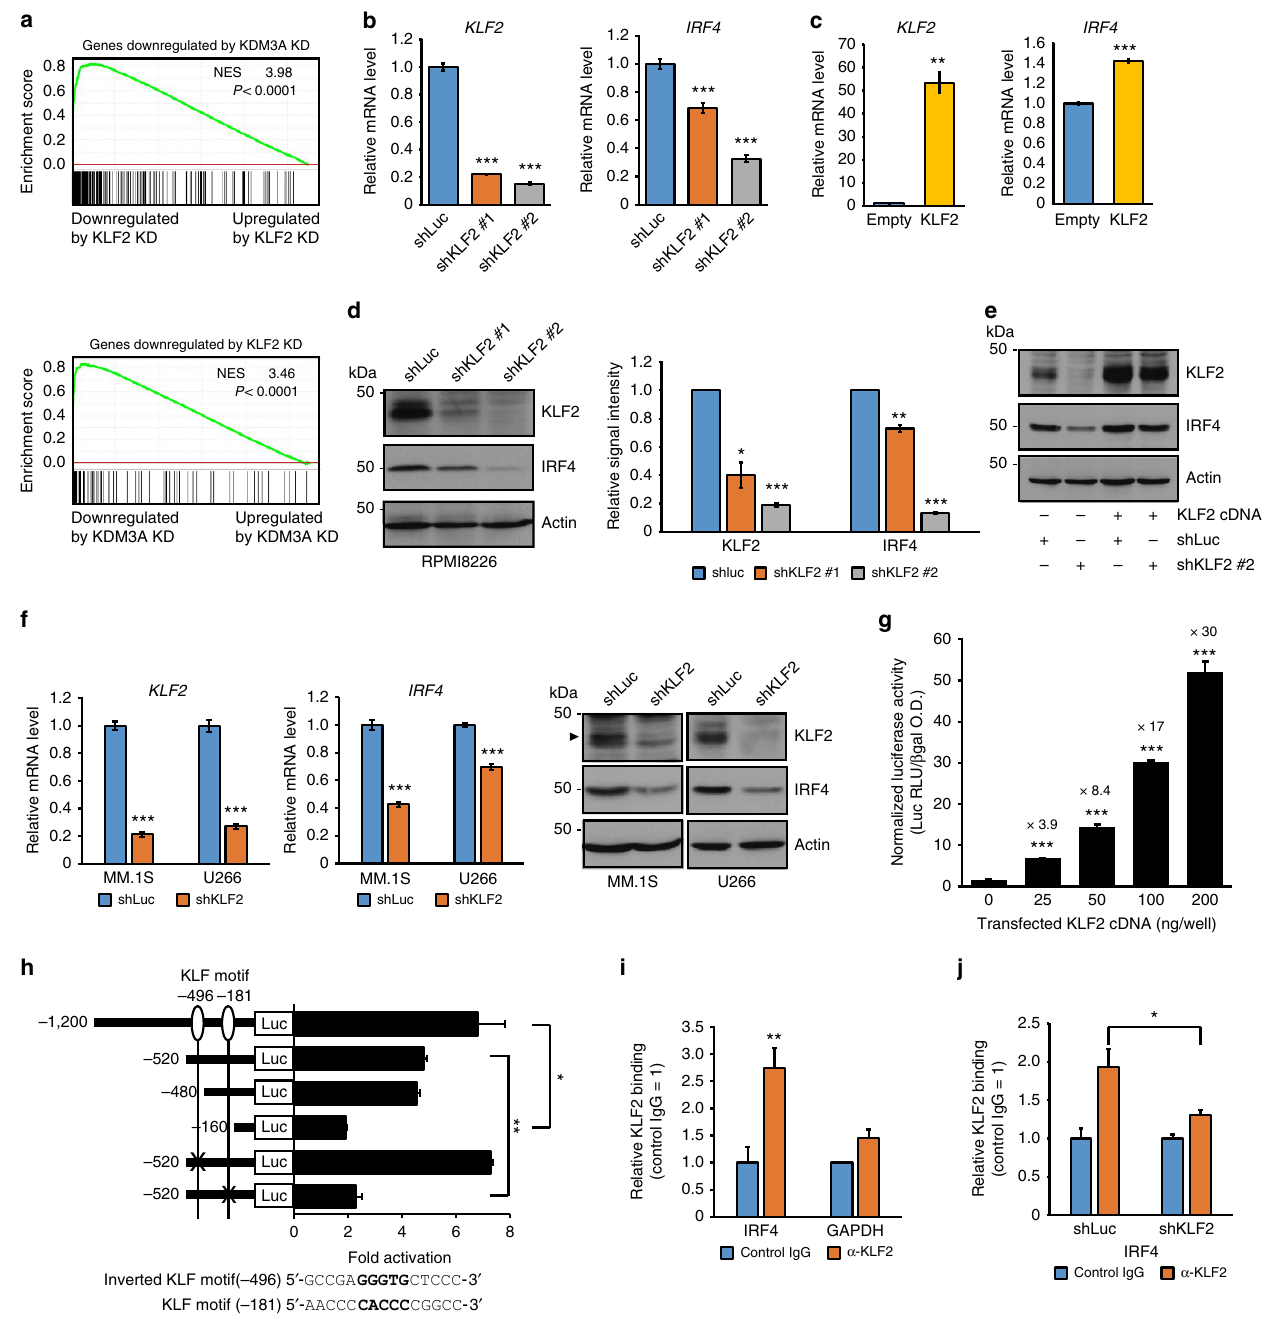
Figure 5 | IRF4 is a direct transcriptional target of KLF2 in MM cells. ( a ) Microarray analysis in RPMI8226 cells transduced with shKDM3A, shKLF2 or shLuc was performed. The genes significantly downregulated by KDM3A or KLF2 knockdown compared with control were used as gene sets for the GSEA. Normalized enrichment score (NES) and P values are shown. ( b , c ) Quantitative real-time PCR of KLF2 and IRF4 after knockdown ( b ) and overexpression ( c ) of KLF2 in RPMI8226 cells. ( d ) Immunoblot analysis of KLF2 and IRF4 after knockdown of KLF2 in RPMI8226 cells. Shown are the relative signal intensity (shLuc ¼ 1) normalized by Actin. Error bars represent s.d. of two independent experiments. ( e ) RPMI8226 cells expressing the KLF2 cDNA carrying synonymous mutations in the shKLF2 #2 target sequence or empty vector were transduced with shKLF2 #2 or shLuc. Whole-cell lysates were subjected to immunoblot analysis. ( f ) Quantitative real-time PCR and immunoblot analysis of KLF2 and IRF4 after knockdown of KLF2 in MM.1S and U266 cells. ( g ) Transactivation of the IRF4 promoter by KLF2. The indicated amounts of KLF2 expression plasmids were transfected into 293Tcells together with the human IRF4 promoter-luciferase reporter. The value above each bar indicates the induction level compared with empty vector. ( h ) 293T cells were co-transfected with the indicated IRF4 -luciferase reporter and 0.04 m g of KLF2 expression plasmid or empty vector, and then assayed for luciferase activity. The fold activation (normalized luciferase activity co-transfected with KLF2 expression plasmid relative to empty vector) is shown. ( i ) ChIP analysis showing KLF2 occupancy on IRF4 promoter in RPMI8226 cells. GAPDH promoter was used as negative control. ( j ) KLF2 occupancy is abrogated by KLF2 knockdown on IRF4 promoter in RPMI8226 cells. RPMI8226 cells transduced with either shKLF2 or shLuc were used for ChIP. For b , c , f , i , j , error bars represent s.d. of triplicate measurements. For g , h , data represent mean ± s.d. of three ( g ) or two ( h ) biological replicates. For b – j , data are representative of at least two independent experiments. * P o 0.05, ** P o 0.01, *** P o 0.001 compared with control; Student’s t